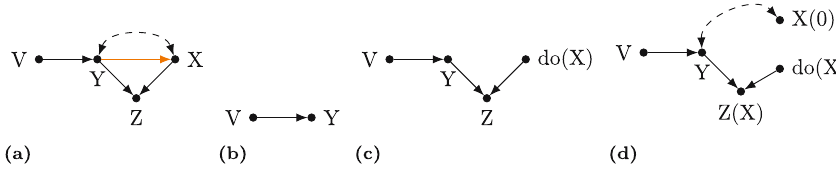
Figure 2: ( a ) Example graph for a data generating process in which the orange Y X → edge is unstable. ( b ) The level 1 operator applied to the graph in ( a ) . The stable level 1 distribution over observed variables is P Y V ( ∣ ) , which ignores all information from X and Z . ( c ) Level 2 operator applied to ( a ) , deleting the edges into X . The level 2 stable distribution is P Y V Z do X , , ( ∣ ( )) .